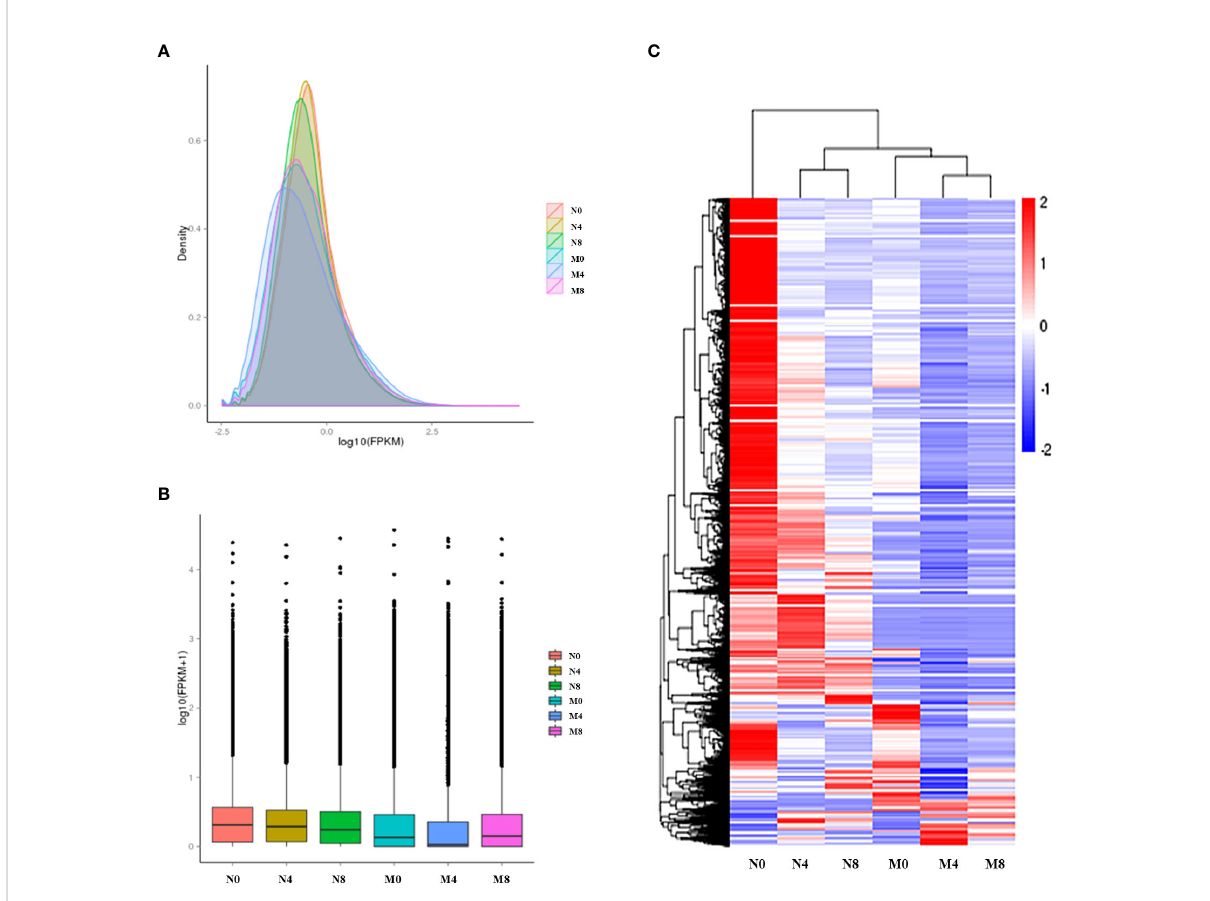
FIGURE 1 Expression analysis of the genes. N0, N4, and N8, represent the alfalfa root samples of Zhaodong respectively after 0 h, 4 h, and 8 h of salt treatment. M0, M4, and M8, represent the alfalfa root samples of Adina respectively after 0 h, 4 h, and 8 h of salt treatment. (A) FPKM density distribution. (B) FPKM distribution. (C) Hierarchical cluster of genes in the six alfalfa samples. The colors represent log2(FPKM value) in each grid, the color key is on the